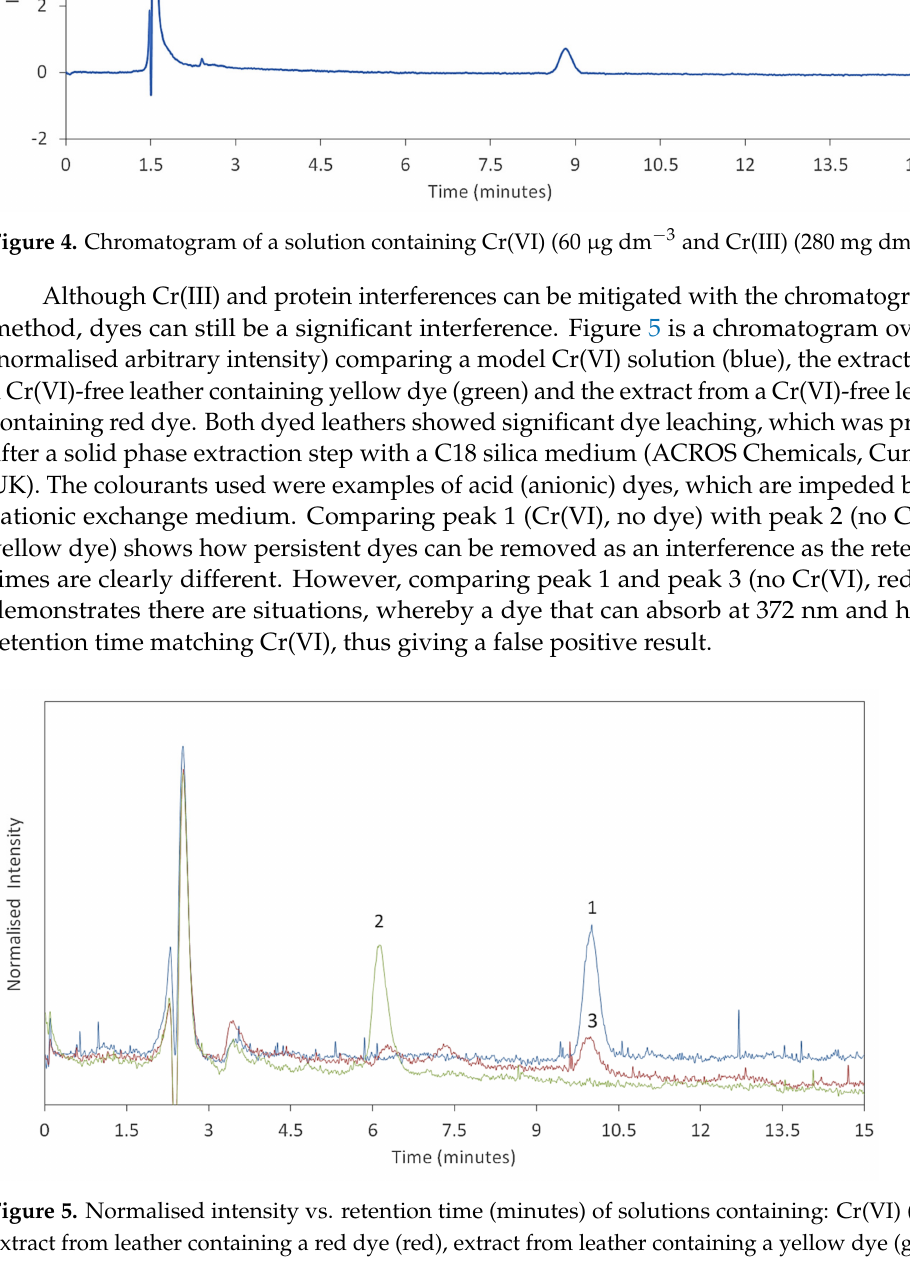
peaks designated in Figure 5: Cr(VI) (peak 1) (blue, absorbances at 272 and 372 nm), extracted yellow dye (peak 2) (green, absorbances at 232, 273 nm), and extracted red dye (peak 3) (red, absorbances at 236, 278 and 328 nm). The UV-visible spectra in Figure 6 provide a clear distinction between the red dye and Cr(VI) peaks, thus confirming